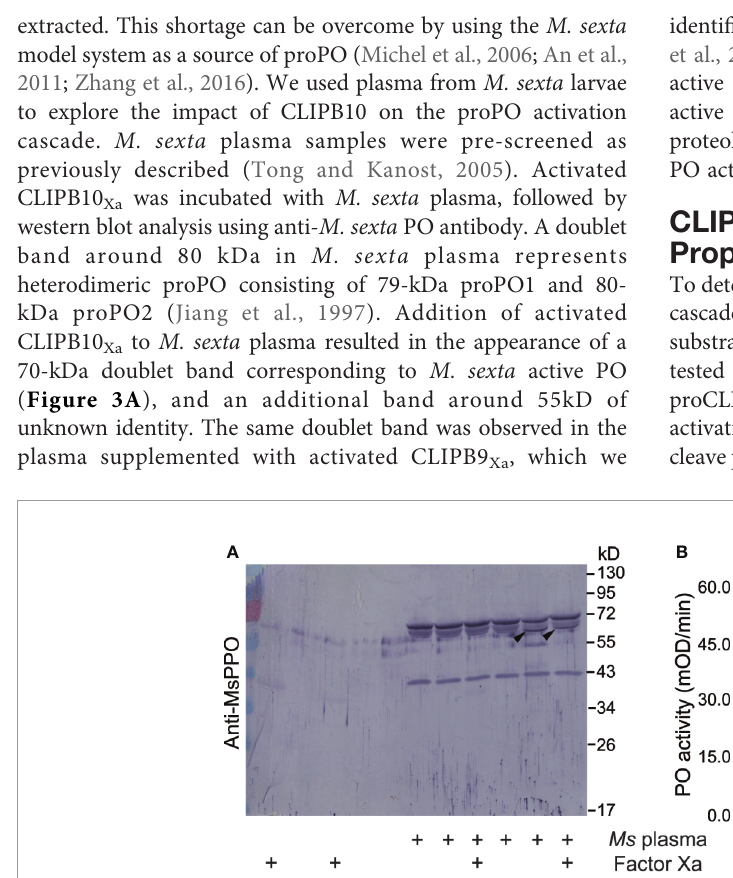
FIGURE 2 | Active CLIPB10 Xa is inhibited by rSRPN2. (A) SDS-PAGE and Coomassie blue staining shows the presence of a covalent complex formed by rCLIPB10 Xa and rSRPN2, indicated by asterisk. CLIPB10 Xa zymogen is indicated by a fi lled star, catalytic domain is indicated by an open star, factor Xa is indicated by diamond, and rSRPN2 is indicated by triangle. (B) IEAR p Na was used as the substrate to measure the residual amidase activity of active CLIPB10 Xa , which was inhibited by rSRPN2 at increasing molar ratios. Data are shown as means ± S.D. (n = 3). The stoichiometry of inhibition is